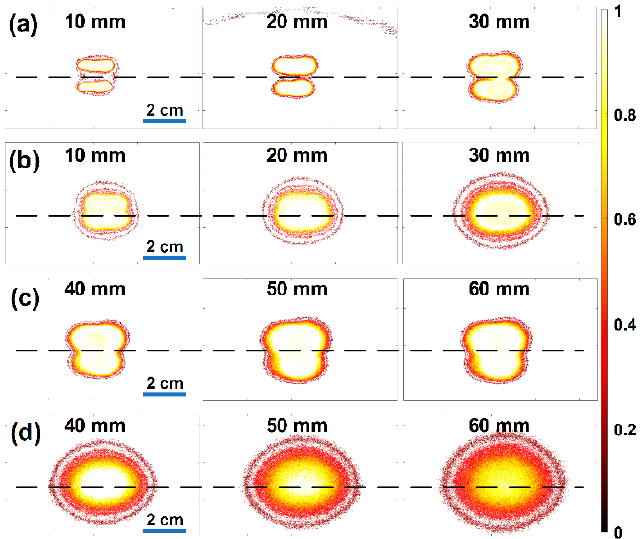
Figure 7. Measured light-intensity distributions at depths of 10 to 60 mm in 10 mm increments: ( a , c ) without the optical lenses and ( b , d ) with the optical lenses. The black dashed lines on each image indicate the imaging plane that is the center position of the US array transducer.